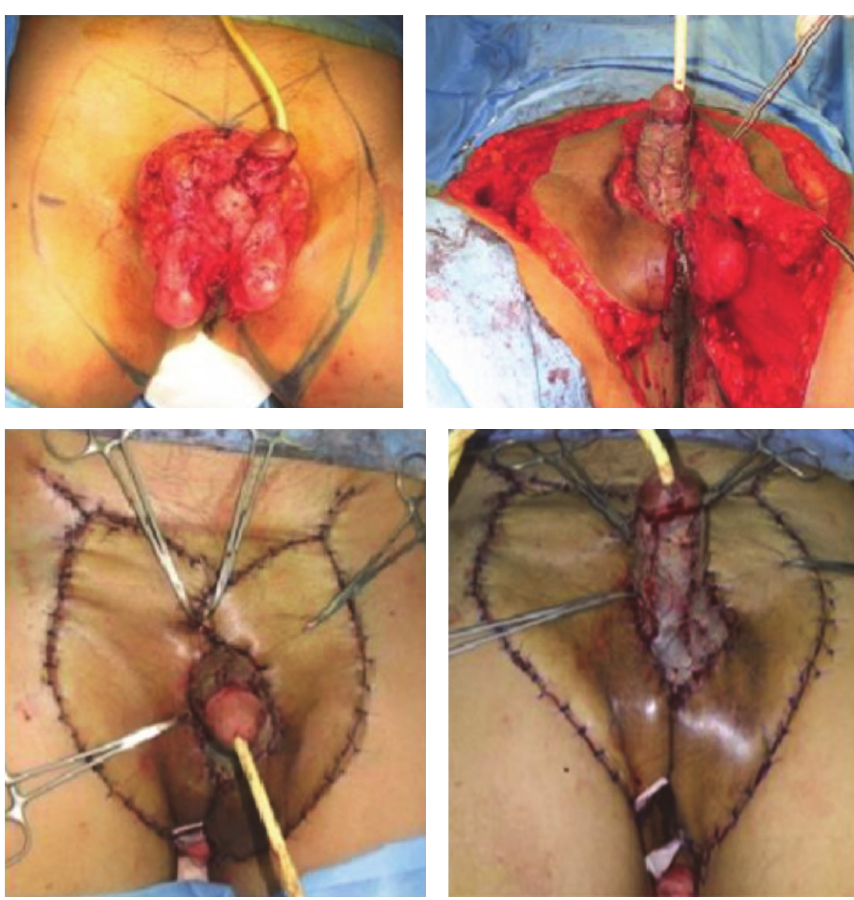
Figure 4: Excision defects were closed by STSG and double keystone